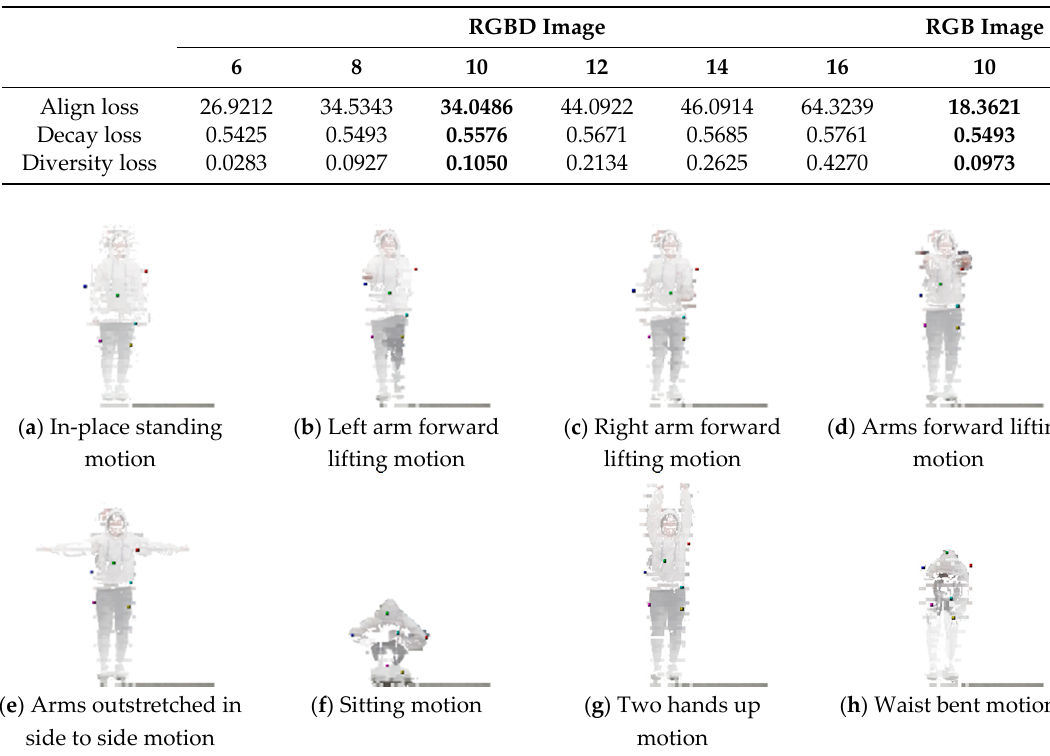
Figure 13. 3D landmarks generated when κ was 6.